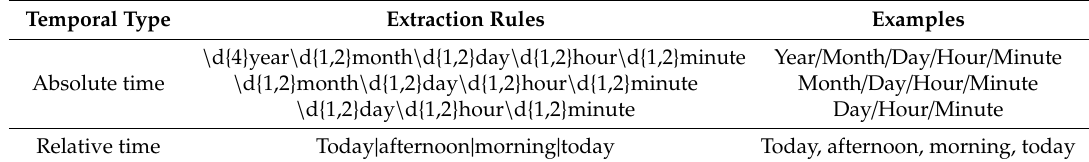
Table 2. Temporal extraction